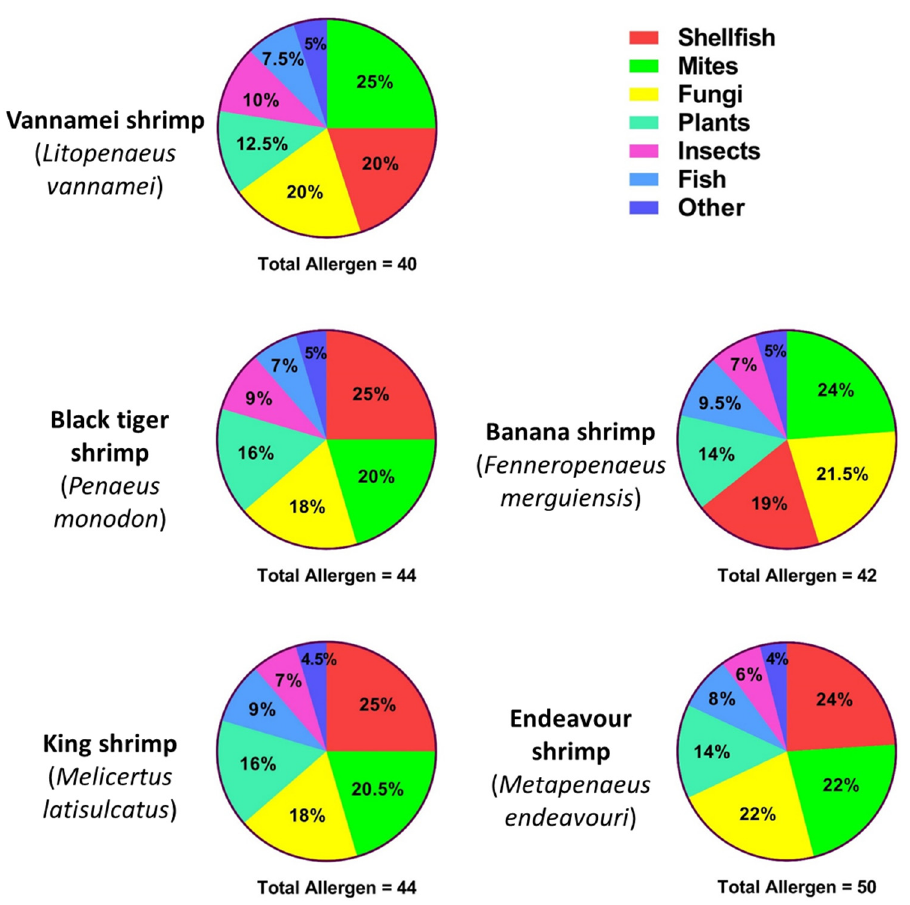
Figure 2. Total allergens identified from the transcriptomic analysis in each of the five shrimp species, distributed based on the matched allergen’s source. The distribution amongst different groups of allergen sources is shown in percentages and arranged in descending order.